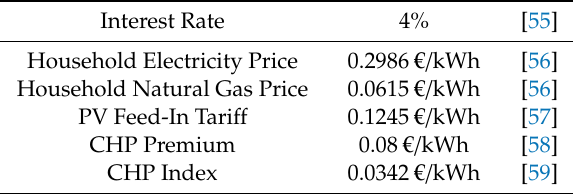
Table 3. State-of-the-art techno-economic technology parameters.